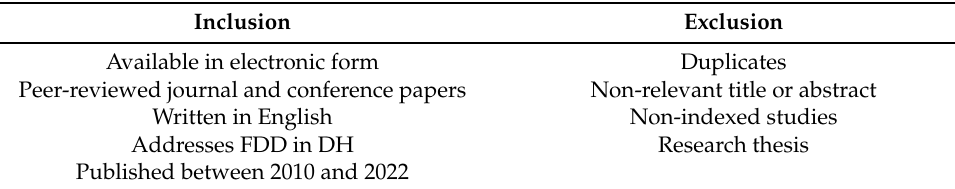
Table 1. Inclusion and exclusion criteria for this survey.